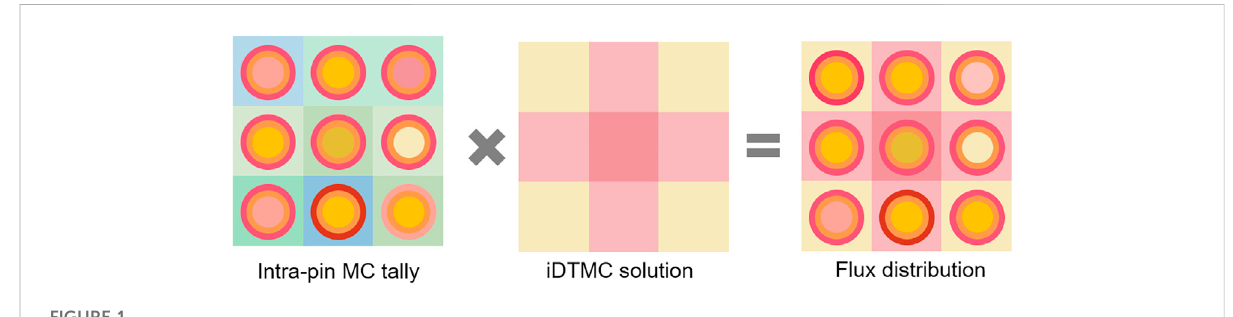
FIGURE 1 Intra-pin renormalization with the MC tally and iDTMC solution.